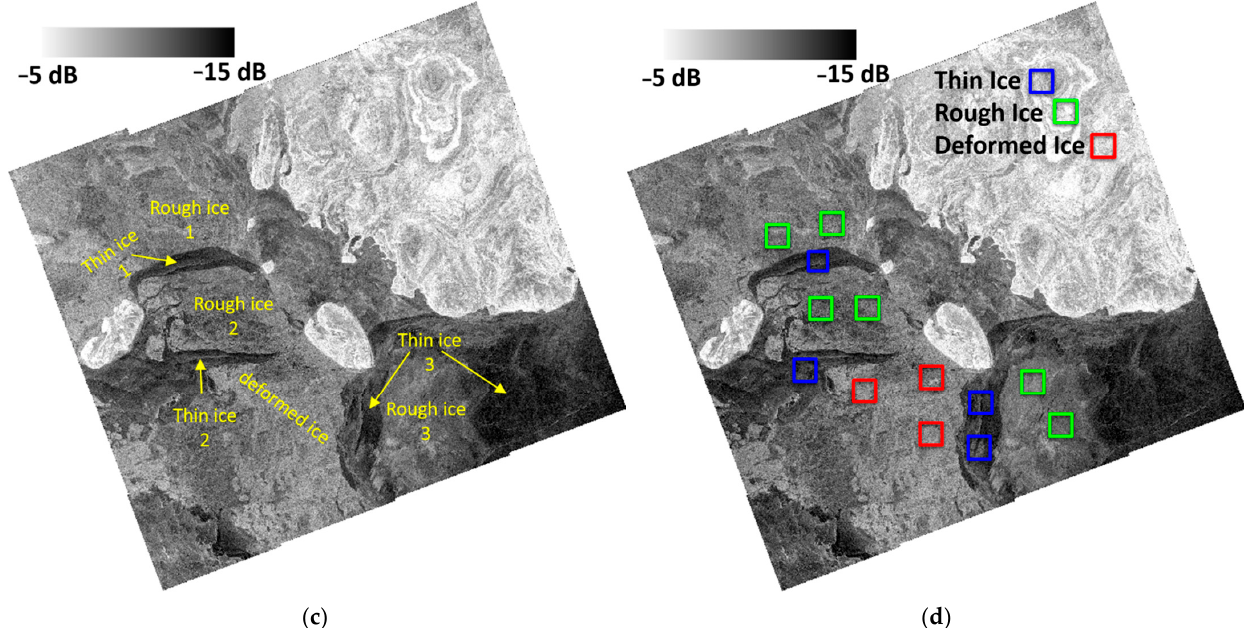
Figure 3. Backscattering coefficients of ( a ) RADARSAT-2 HH, ( b ) RADARSAT-2 HV, ( c ) RCM RH, and ( d ) RCM RV.